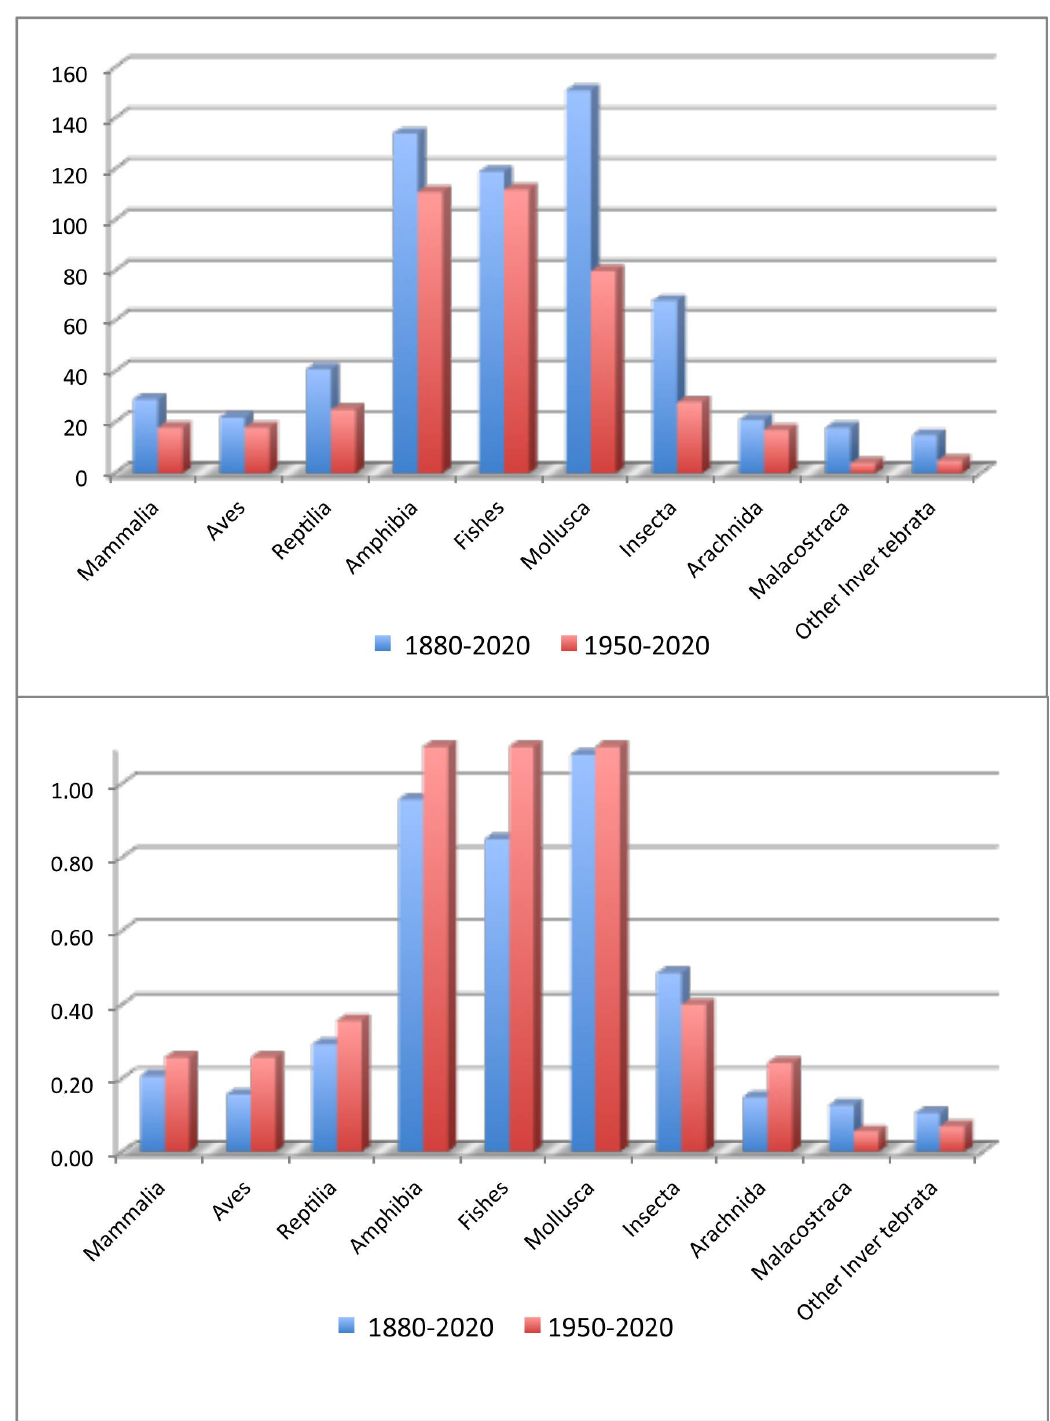
Figure 1. Comparison between the number of species extinct during the last 140 and 70 years in the major taxonomical groups of animals (data from [95]) ( above ), and between their annual average extinction rates ( below ).